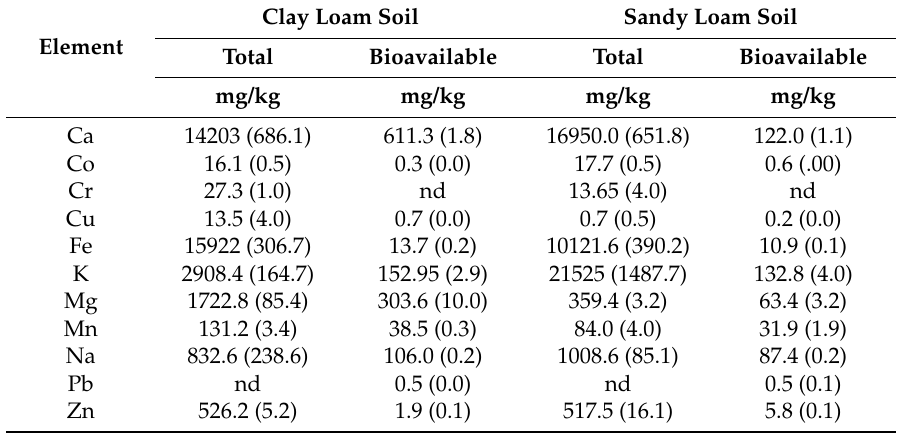
Table 3. The trace element contents of soils used in the pot experiment. The DTPA and Aqua regia extractions were used to determine bioavailable and total trace elements, respectively. Numbers in parentheses are the standard errors of the means of three